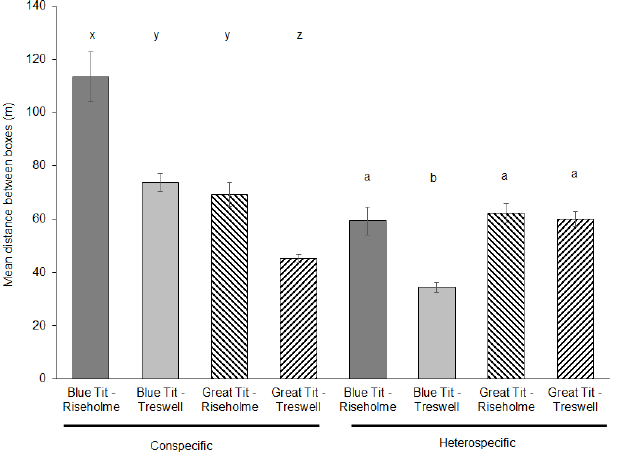
Fig. 3 . Mean (± SD) distances to a box nearest to a box containing a focal bird that contains either a conspecific or a heterospecific for Great Tits ( Parus major ) and Blue Tits ( Cyanistes caeruleus ) nesting at Riseholme Park or Treswell Wood. Columns with different superscripts, x,y,z (conspecific) or a,b (heterospecific), indicate significant differences at a P - value of 0.05.